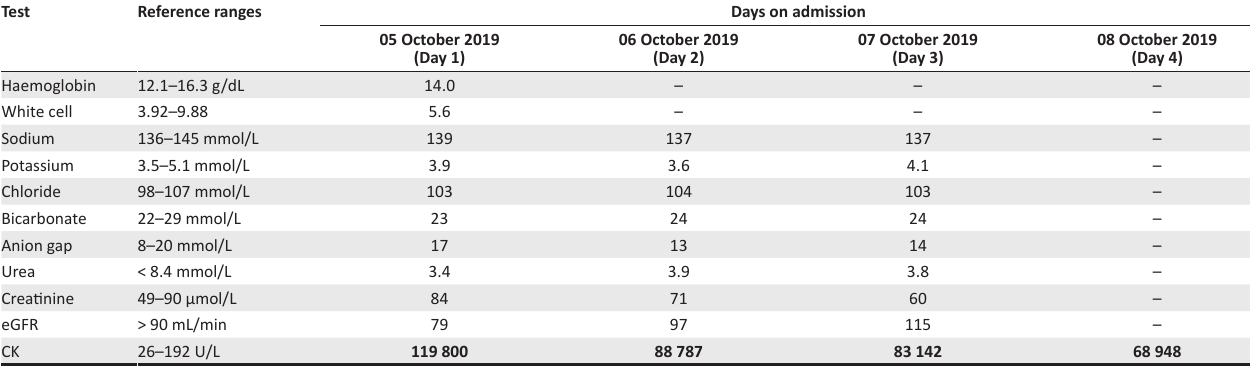
TABLE 1: Relevant investigations during admission.